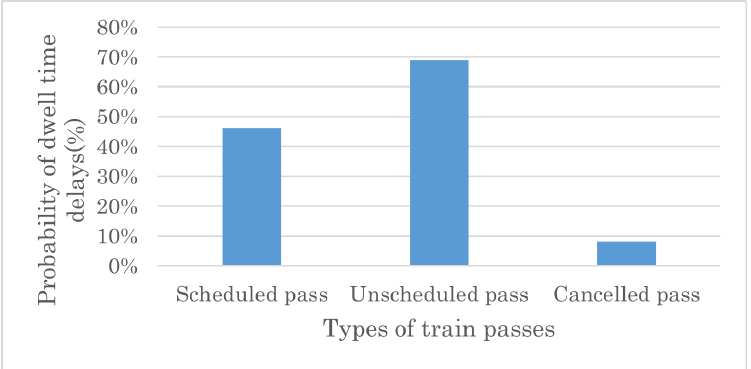
Figure 4. Probability of dwell time delays for different types of train passes.